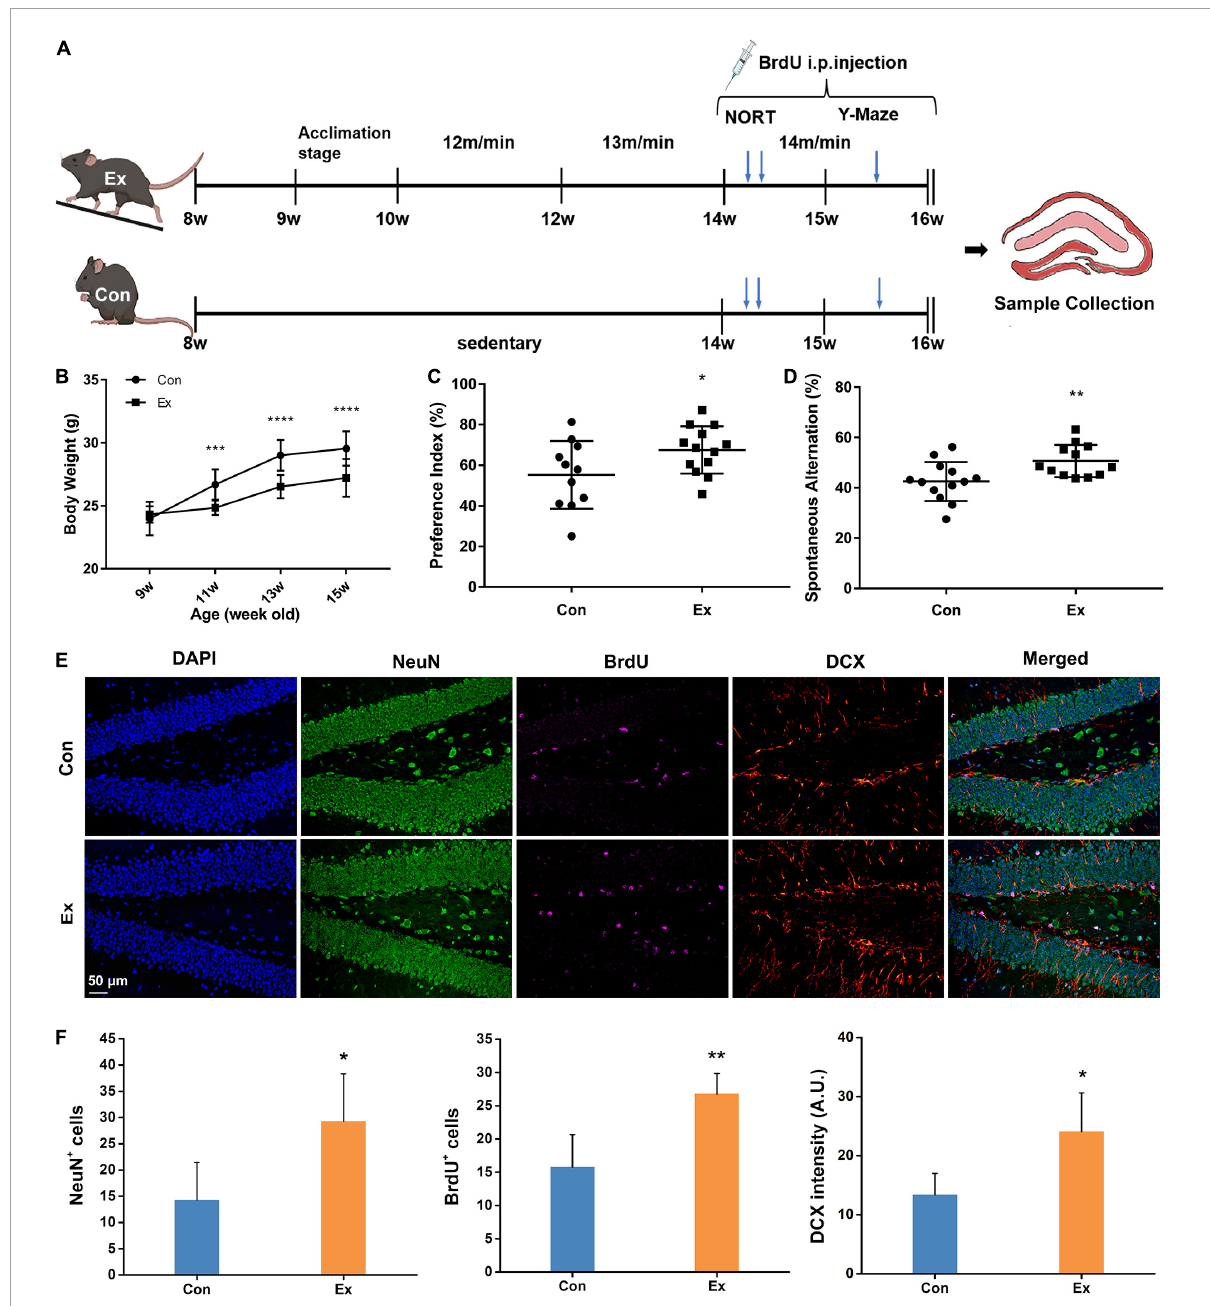
FIGURE1 Experimental design and response to chronic exercise. (A) Schematic diagram of moderate-intensity chronic exercise model. After habitation to the new environment, mice in Ex group received chronic exercise containing acclimation stage (1 week) and training stage (6 weeks), while the Con mice remained in the same room without access to the treadmill. In a separate cohort, novel object recognition test (NORT) and Y-maze test were performed in the fifth or sixth week of the training stage. BrdU was intraperitoneally injected for last 14 days before scarification. (B) Physical response to chronic exercise. Chronic exercise significantly inhibited the growth-related gain of body weight ( n = 13). *** p < 0.001, **** p < 0.0001 Ex vs. Con at each time point, two-way ANNOVA test. (C,D) Cognitive response to chronic exercise assessed by NORT and Y-Maze test ( n = 11–13). Compared with the control, chronic exercise significantly improved novel object recognition memory ( p = 0.0458) and spatial working memory in the Ex group ( p = 0.009). Each dot represents one mouse. (E) Representative immunofluorescence images of NeuN, BrdU, and DCX for hippocampal adult neurogenesis. Scale bar = 50 µ m. (F) Quantitative analysis of NeuN, BrdU, and DCX cells in the hippocampus. Compared with the Con ( n = 6), Ex mice ( n = 6) had more NeuN + ( p = 0.041), BrdU + ( p = 0.0092), and DCX + cells ( p = 0.0293) in the dentate gyrus of the hippocampus. For panels (C,D,F) , data are presented as mean ± SEM, * p < 0.05, ** p < 0.01 Ex vs. Con were calculated by unpaired Student’s t -test. Con, control; Ex, exercise; NeuN, neuronal nuclei; BrdU, 5-bromo-2 (cid:48) -deoxyuridine; DCX,